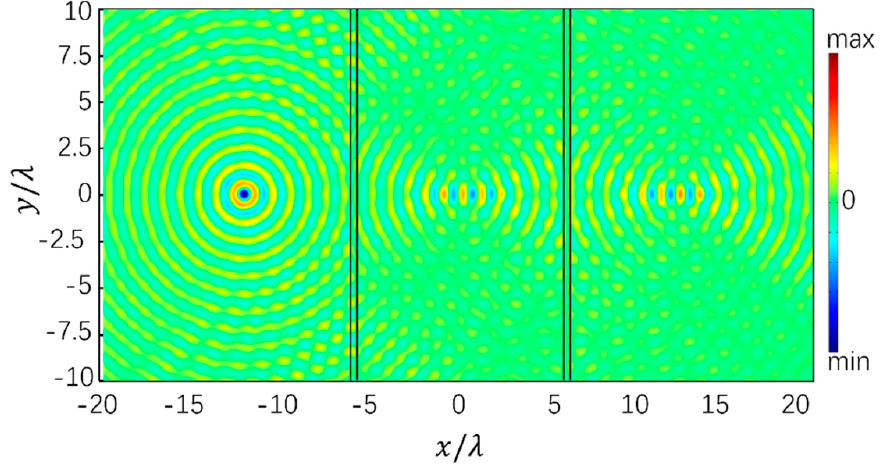
Figure 7. Planar focusing using PIM-air-PIM*